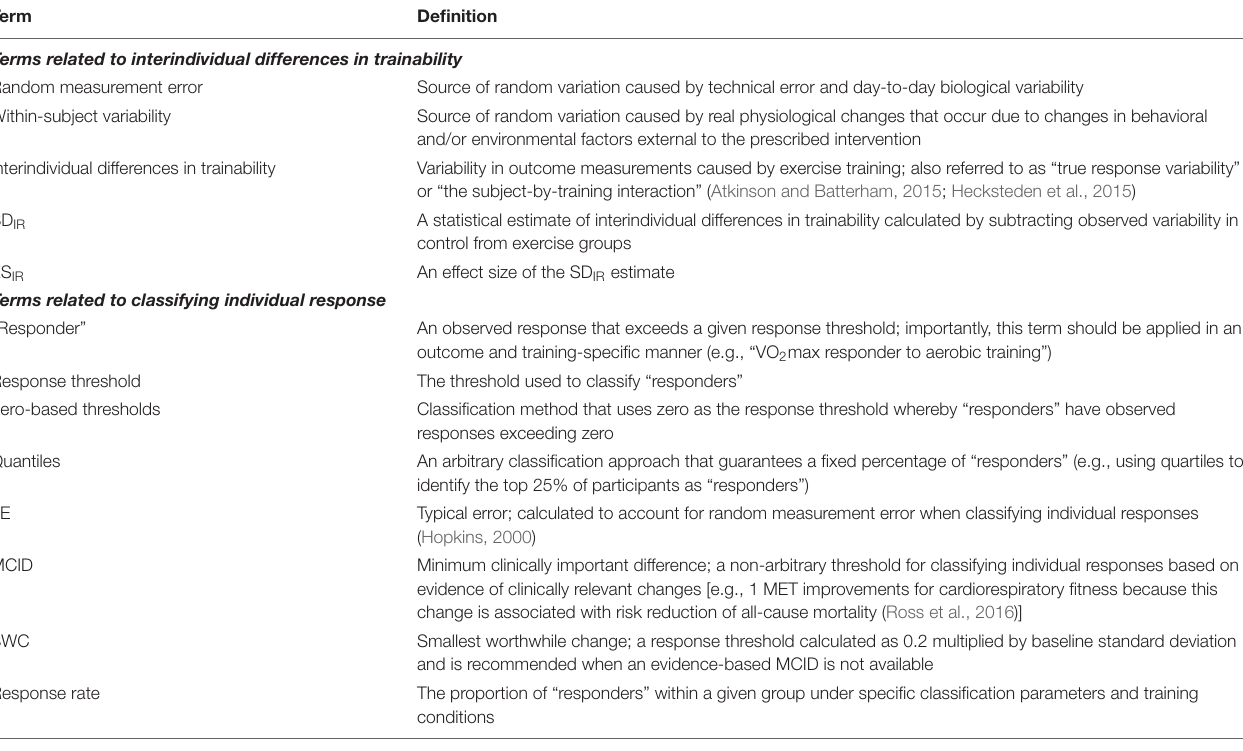
TABLE 1 | Definitions of individual response terms used throughout the present review.